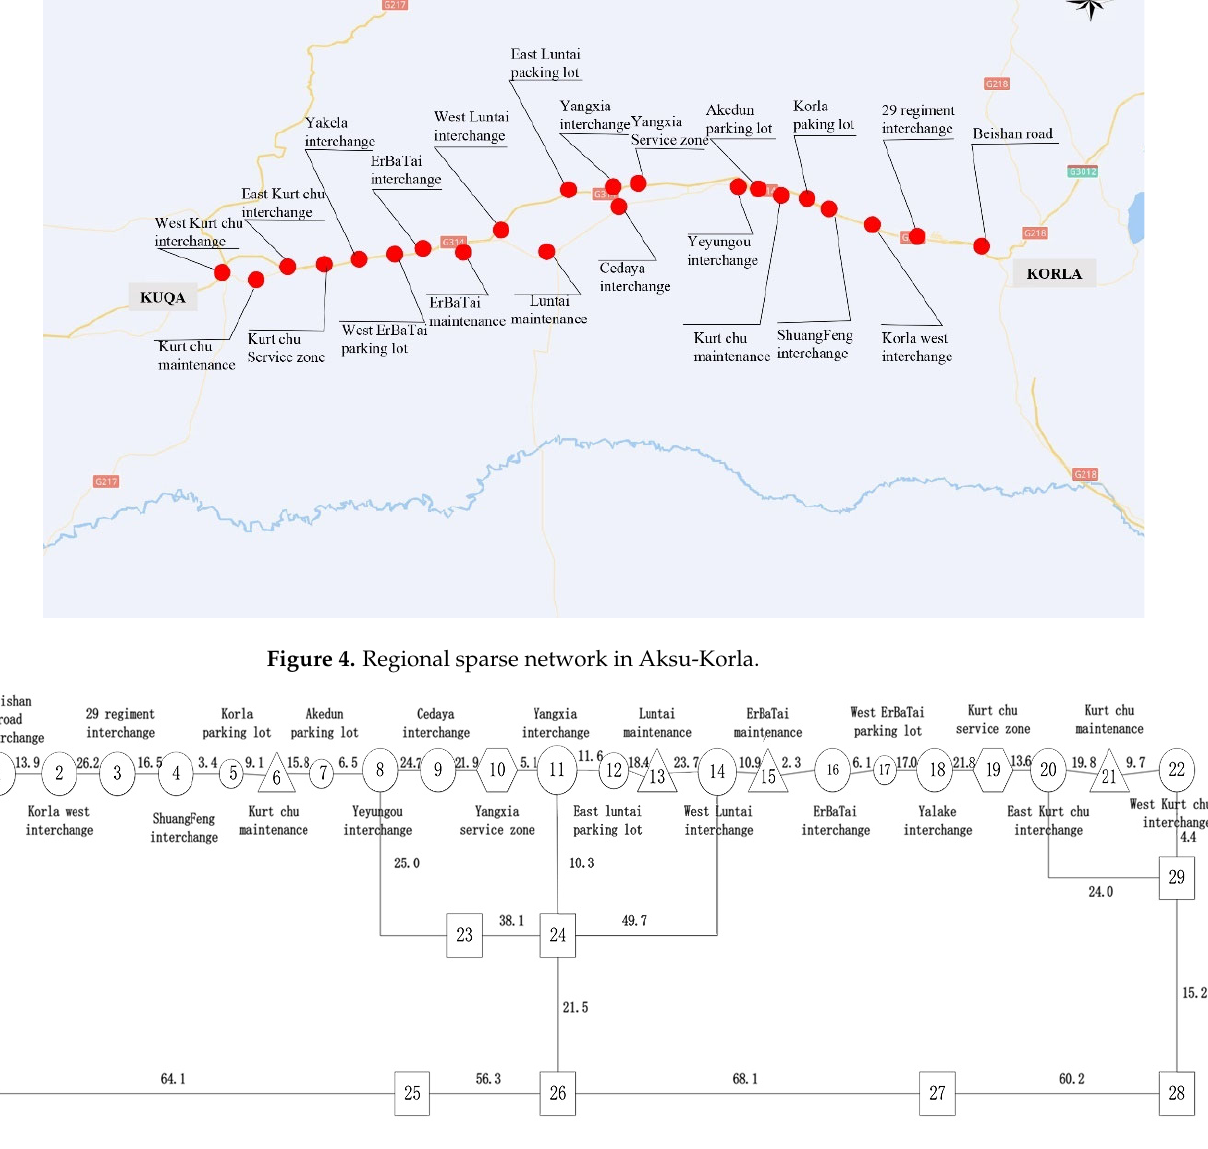
Figure 5. Regional sparse network KK.